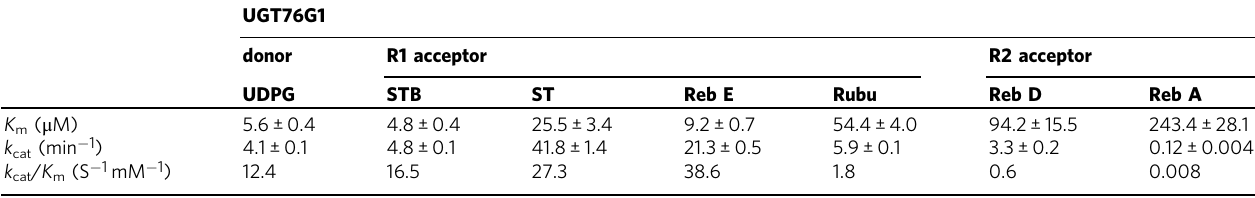
Table 1 Enzyme kinetic parameters for the single sugar transfer of UGT76G1